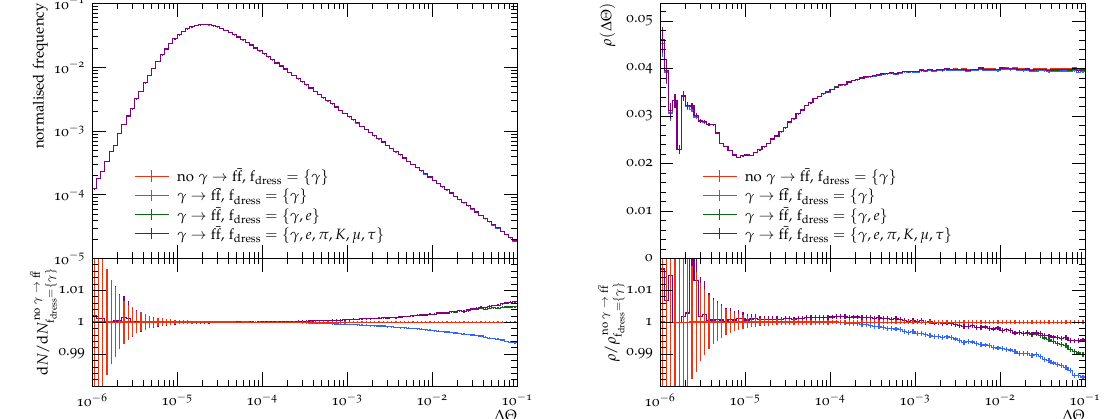
Figure 6 . Left: the differential distribution of the dressed lepton constituents, including radiated photons with E γ > 0 . 1 MeV, in dependence on the angular distance ∆Θ from the primary lepton. Right: the energy density ρ within the dressed lepton as a function of the angular distance ∆Θ from the primary lepton. Shown are the predictions without accounting for photon splittings (red), compared to the predictions allowing photons to split: dressed with photons only (blue), photons and electrons (green) or all particles